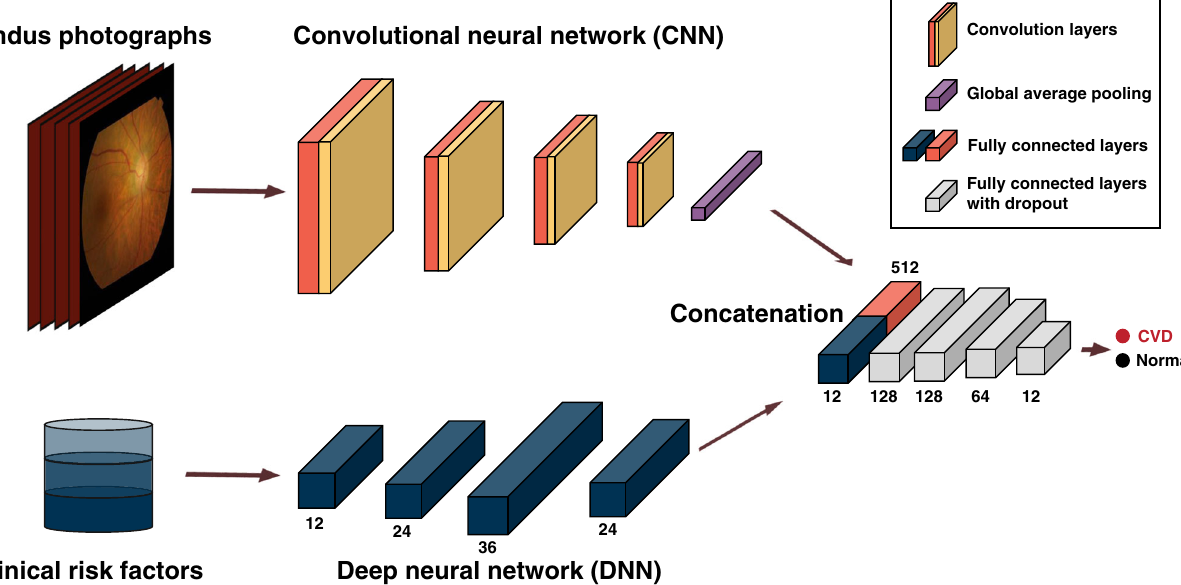
Fig. 1 Illustration of multimodal architecture which combines CNN with DNN to feed fundus photographs and clinical risk factors. DenseNet-169 architecture with convolution layers (i.e., dense blocks) is used for CNN. The number of nodes is speci fi ed at each fully- connected layer. The last three layers have a dropout rate of 0.3. DNN deep neural network, CNN convolutional neural network.